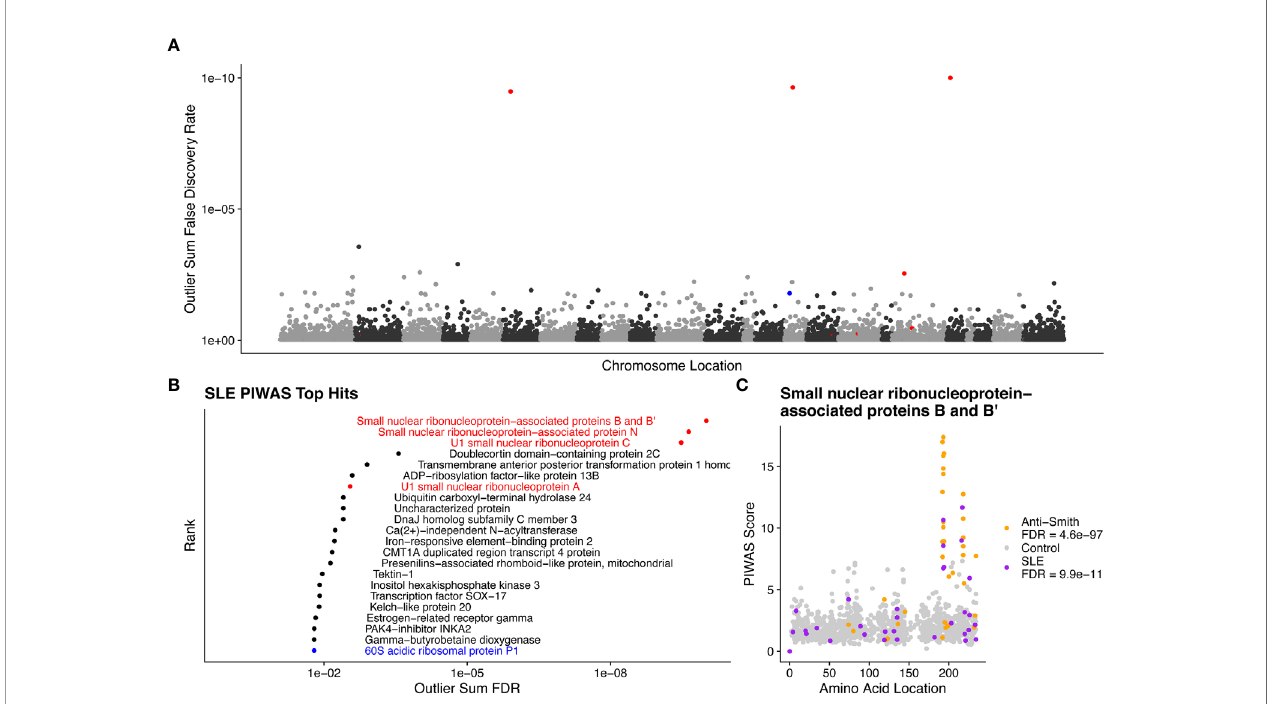
FIGURE 4 | Literature reported and putative autoantigens are detected in SLE samples by PIWAS. (A) PIWAS results from a comparison of SLE samples to controls against the human proteome were prioritized using outlier sum false discovery rate (FDR) as a measure of signi fi cance (y-axis, see Methods ). For visualization, proteins were laid out according to chromosome location. (B) Among the top set of 22 ranked proteins, 5 are established autoantigens (Smith family in red, others in blue). (C) Strength (y) and location (x) of PIWAS scores for the small nuclear ribonucleoprotein-associated proteins B and B ’ within SLE (n=31, purple) vs. control (n=1,157, grey). A cohort of anti-Sm predicate positive patients (n=35, orange) were compared to the same controls to validate the signal obtained using SLE specimens with unknown anti-Sm